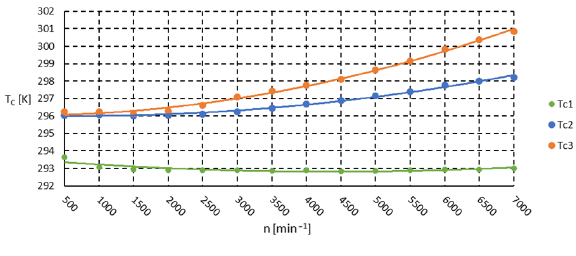
differencesFigure 12. Total temperature data